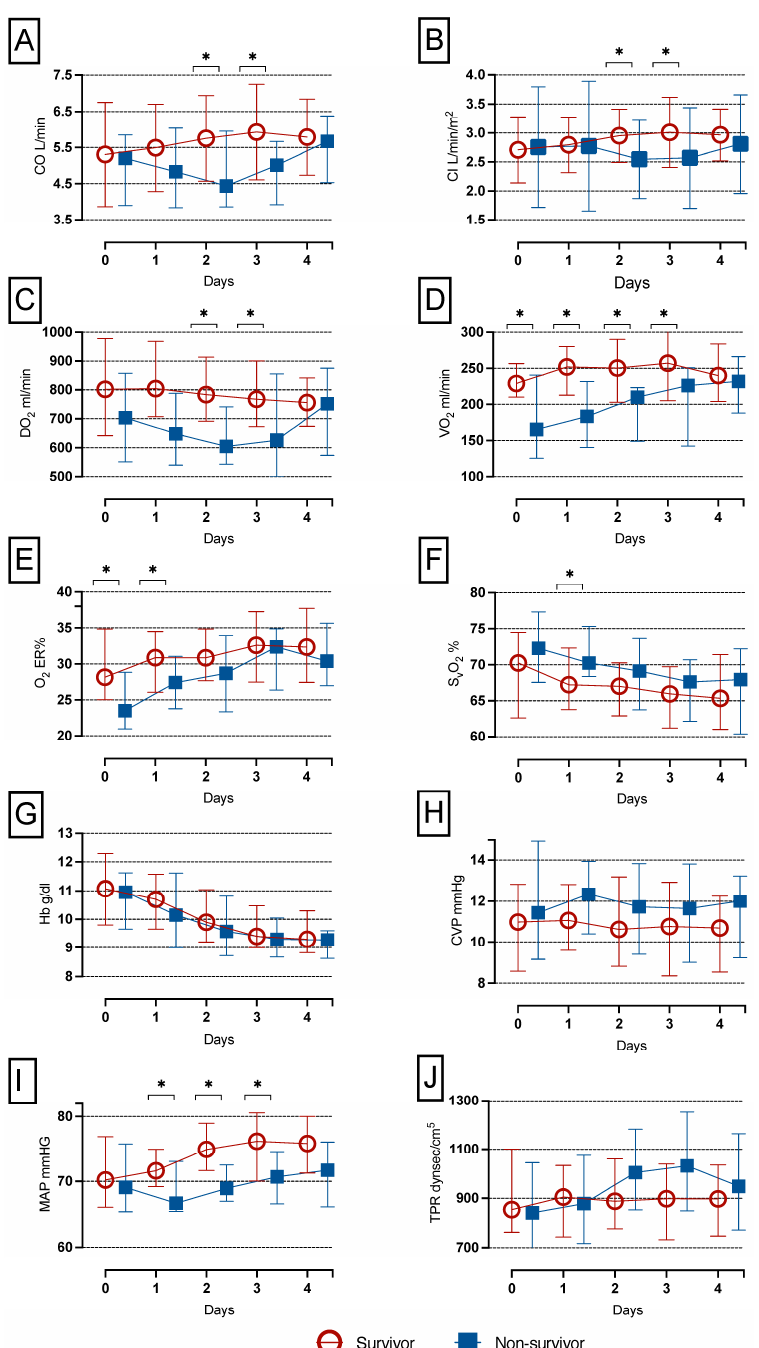
Figure 1. CO, CI, VO 2 , DO 2 , O 2 ER and SvO 2 levels of in-hospital survivors and non-survivors after LVAD implantation. In non-survivors CO, CI and DO 2 were significantly lower compared to survivors on days 2 and 3 ( A – C ). VO 2 was significantly lower in non-survivors compared to survivors during the first 3 days after surgery ( D ). Non-survivors had significantly lower O 2 ER values on postoperative days 0 and 1 compared to survivors ( E ). SvO 2 was significantly higher in non-survivors compared to survivors on day 1 ( F ). There was no difference in Hb and CVP between survivors and non-survivors ( G , H ). In contrast, there were significantly higher MAP levels in survivors compared to non-survivors from day 1 until day 3 ( I ). TPR did not differ between survivors and non-survivors ( J ). CO, continuous cardiac output; CVP, central venous pressure; DO 2 , oxygen delivery; O 2 ER, oxygen extraction ratio; SvO 2 , mixed venous oxygen saturation; VO 2 , oxygen consumption; * p <